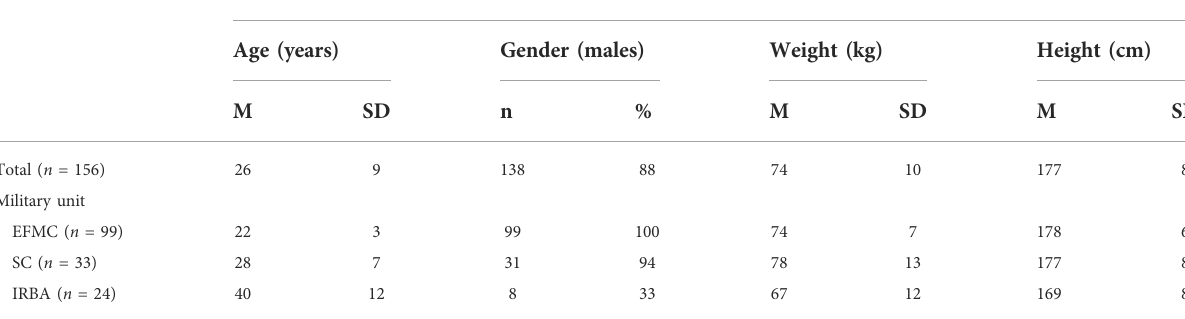
TABLE 2 Summary of demographic (age and gender) and biometric (weight and height) data for the three military units from which the examples originated. These data pertain to the 156 subjects selected from the study (see Participants section).